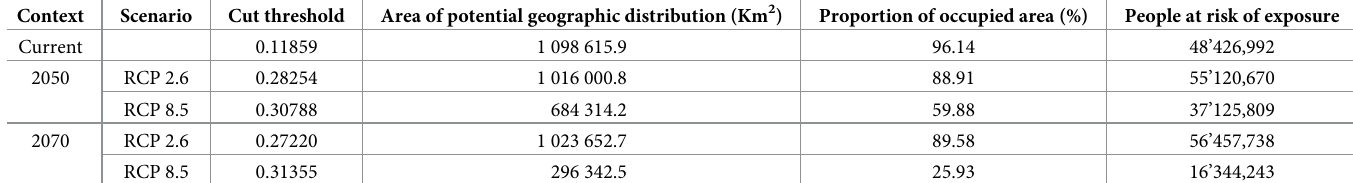
Table 3. Areas of current and future potential distribution of A . albopictus in Colombia.